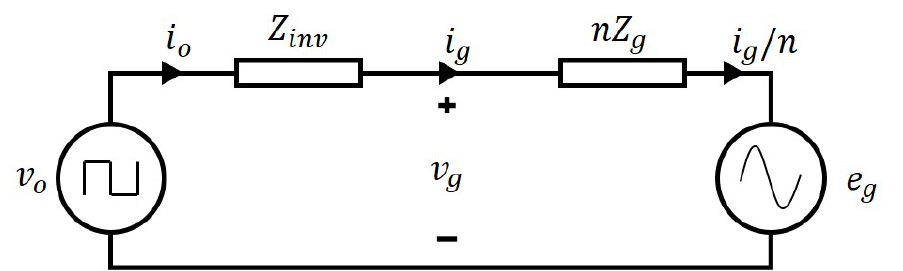
Figure 5. Equivalent circuit of inverter output impedance and effective grid impedance with n paralleled